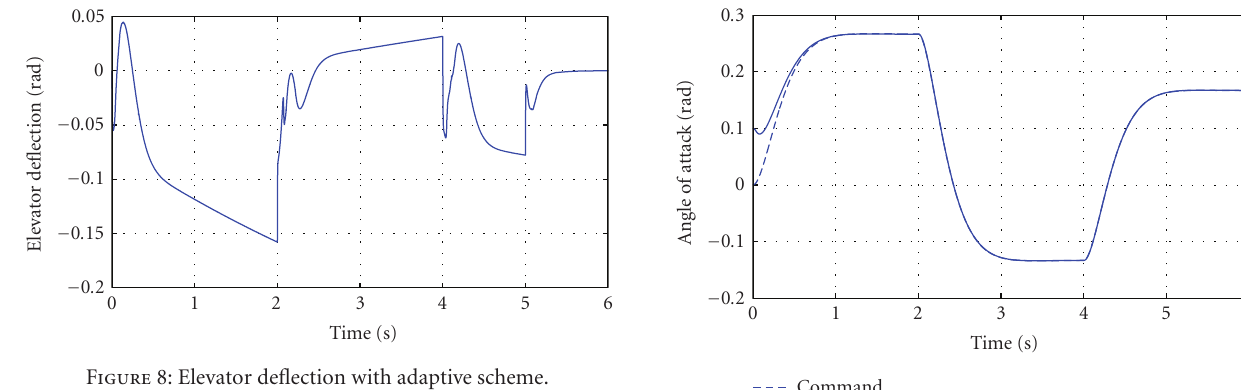
Figure 8: Elevator deflection with adaptive scheme.